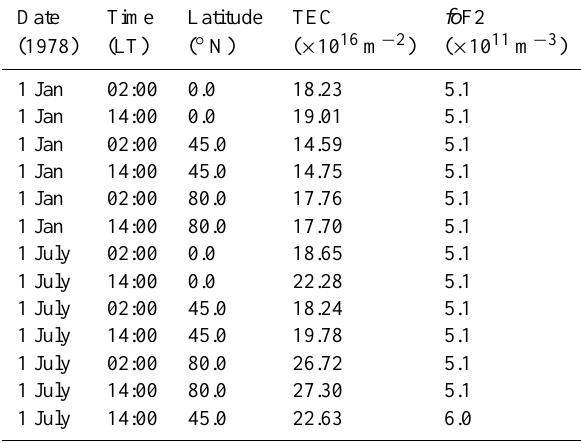
Table 1. Various IRI generated electron density profiles. All pro- files are generated at 75.7 ◦ W longitude